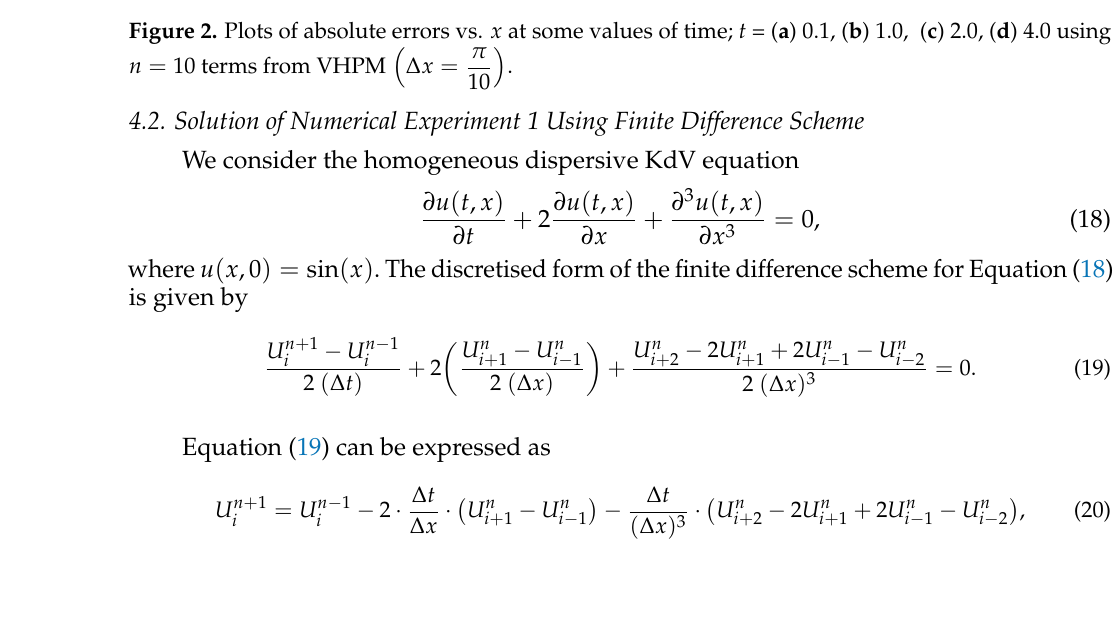
(cid:16) (cid:17) ∆ x = π 10